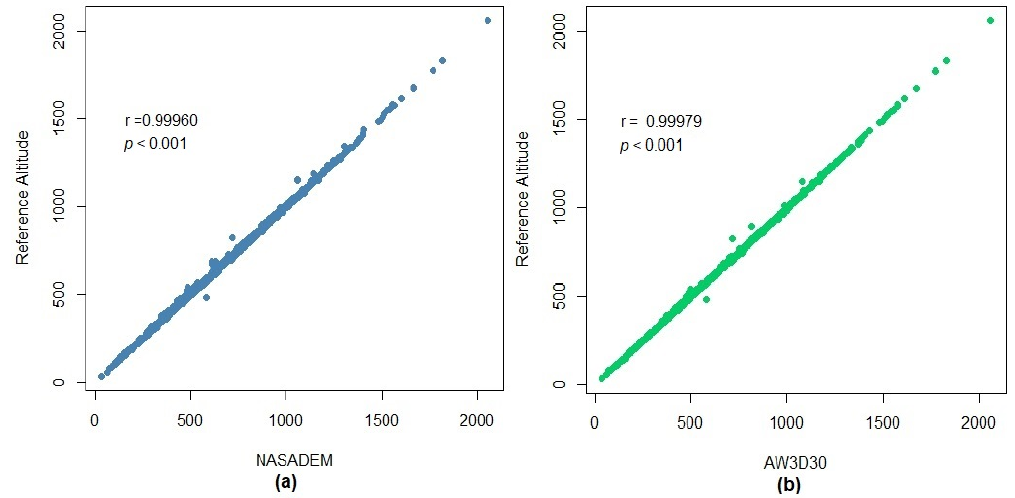
Figure 5. Relation between reference altitudes and those estimated by the NASADEM_HGT ( a ) and AW3D30 ( b ) models.